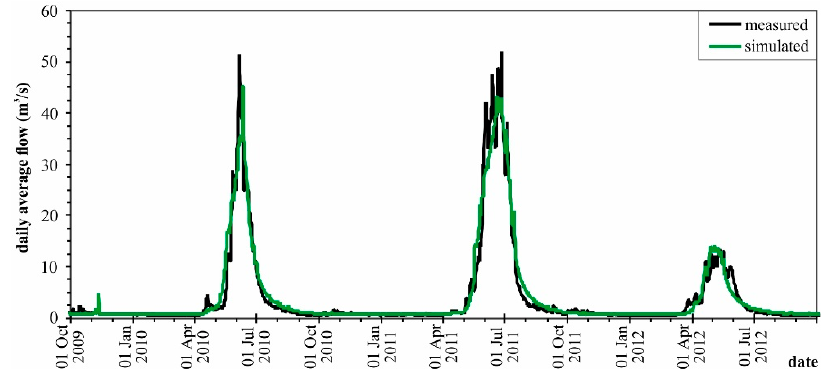
Figure 3. Simulated natural and measured modified daily average flow for the reference watershed for a subset of the time period showing average (2010), wet (2011), and dry years (2012).